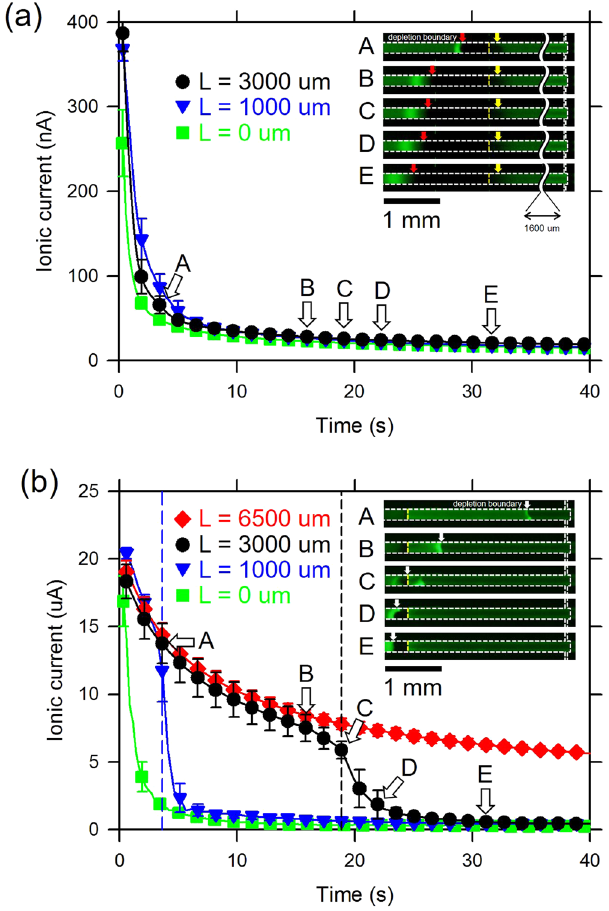
Figure 5. Current-time responses of ( a ) 0.01 × PBS media (~1.5 mM; dilute limit) and ( b ) 1 × PBS media (~150 mM; condensed limit) with the various protruded length. Each figures had an inset of microscopic views in the case of L = 3000 um. Capital letters indicated the time at which the snapshot were